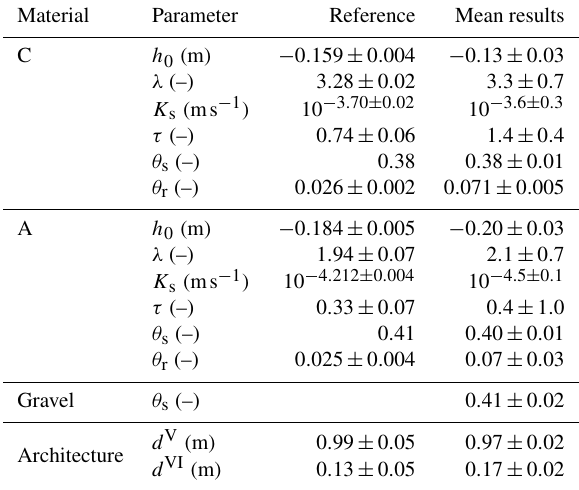
Table 3. The mean and the standard deviation are calculated us- ing the resulting parameters from the 10 best ensemble members (Sect. 3.1.2) estimated from measured data. The corresponding ma- terial functions are shown in Fig. 15. The reference parameters for the materials A and C are determined from TDR data acquired dur- ing the same experiment (Jaumann and Roth, 2017). Note that the standard deviations for these reference parameters are determined from a single Levenberg–Marquardt run and thus are only represen- tative for one local minimum. Also, these standard deviations are given with the understanding that they are specific to the applied al- gorithm and will change for different algorithm parameters. Hence, these standard deviations are in particular not suitable to compare the precision of the TDR and GPR evaluation. For the TDR eval- uation, the porosity of the materials is assumed to be known from core samples. The reference parameters for the subsurface architec- ture are calculated from ground truth measurements acquired dur- ing the construction of ASSESS. The corresponding standard devi- ations are given according to Buchner et al.